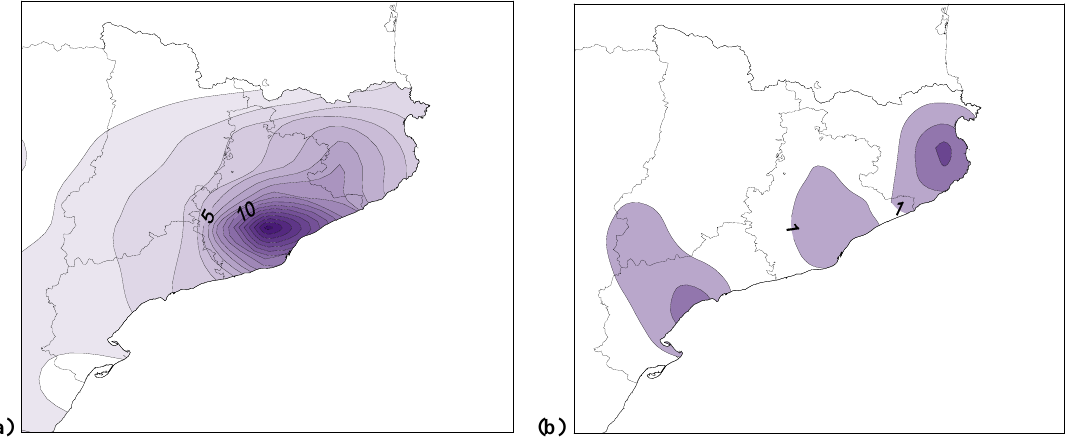
Figure 7. Contours of tornado occurrence density for the periods 1980-2009 (a) and 1950-1979 (b). The interval contours are 1 case/0.5ºx0.5º latitude longitude.